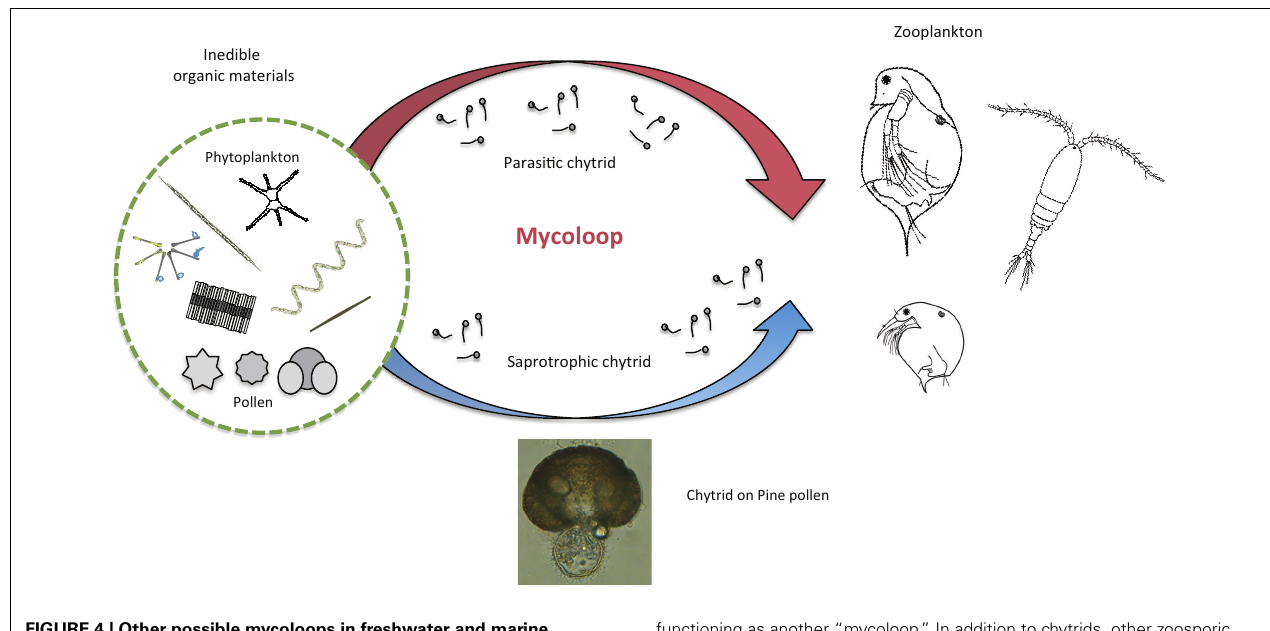
functioning as another “mycoloop.” In addition to chytrids, other zoosporic fungi or fungal-like protists, such as Cryptomycota and Labyrinthulomycota, can infect phytoplankton or consume large inedible organic material, which may be grazed by zooplankton in freshwater and marine